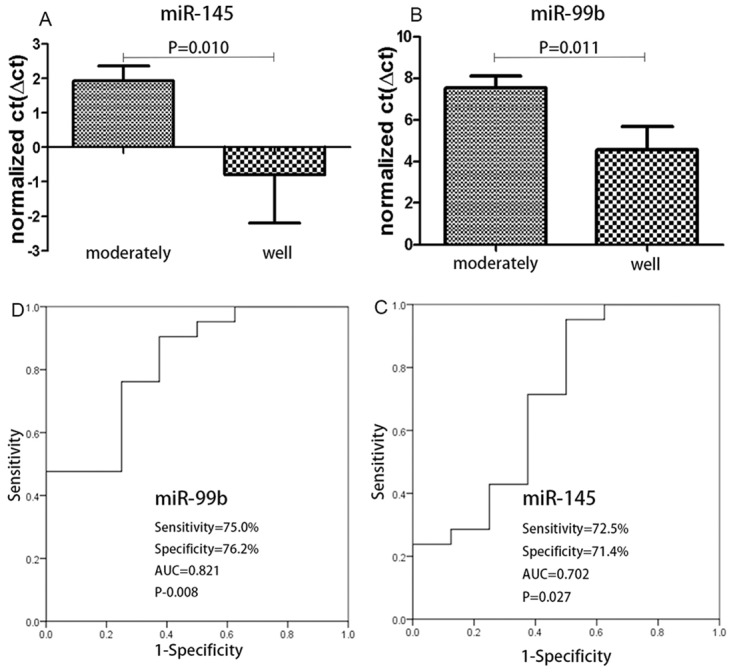
Analysis of the correlation of dysregulated miRNAs (miR-145 and miR-99b) according to the degree of tumor differentiation.The results of the ROC analysis show that miR-145 and miR-99b could not only distinguish cancer samples from normal control samples but also identify well- and moderately differentiated tumors with high sensitivity and specificity.